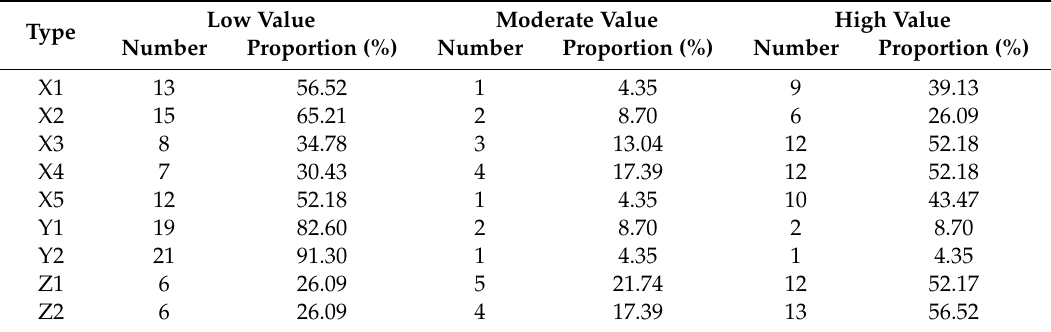
Table 3. The number and proportion of villages at di ff erent intervals of each